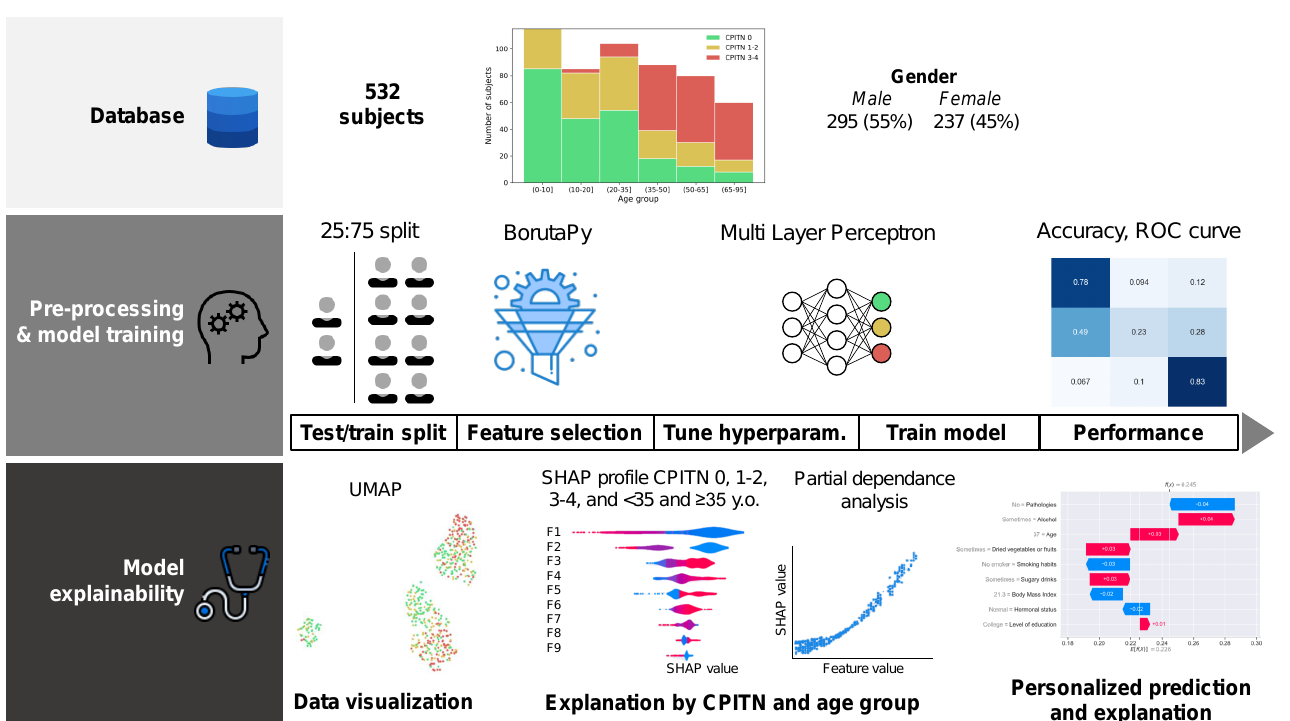
Figure 1. Machine learning analysis pipeline. The analysis pipeline involves three successive steps: (1) constitution of the database with sociodemographic, general medical status, stress, and dietary habits from 532 subjects, together with the periodontal health condition (CPITN); (2) development of the prediction algorithm and evaluation of its performance; (3) model explainability, based on cluster-based visualization of data, SHapley Additive exPlanations (SHAP) profile at the global and individual